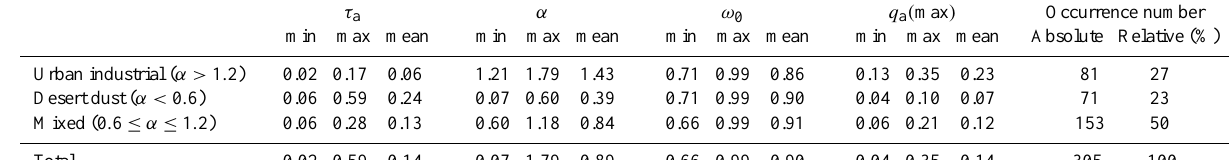
Table 2. Minimum (min), maximum (max), and mean values of τ a , α , ω 0 , and q a ( max ) for 305 selected measurements in each dominant category of aerosols in Zanjan’s atmosphere, February 2010 to December 2012, IASBS site. τ a α ω 0 q a ( max ) Occurrence number min max mean min max mean min max mean min max mean Absolute Relative (%) Urban industrial ( α > 1 . 2)